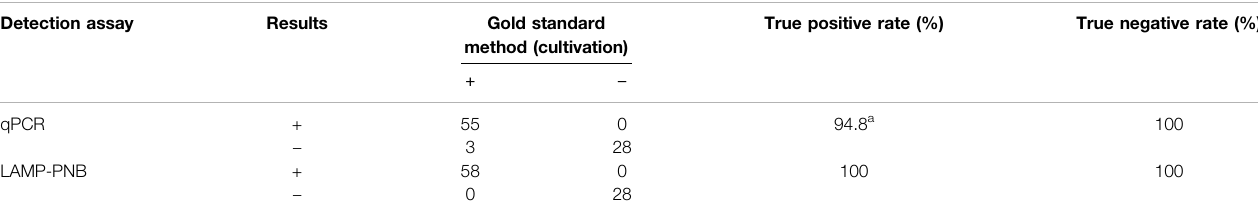
TABLE 3 | Comparison of conventional culture, qPCR, and LAMP-PNB methods for testing N. gonorrhoeae in clinical samples. Detection assay